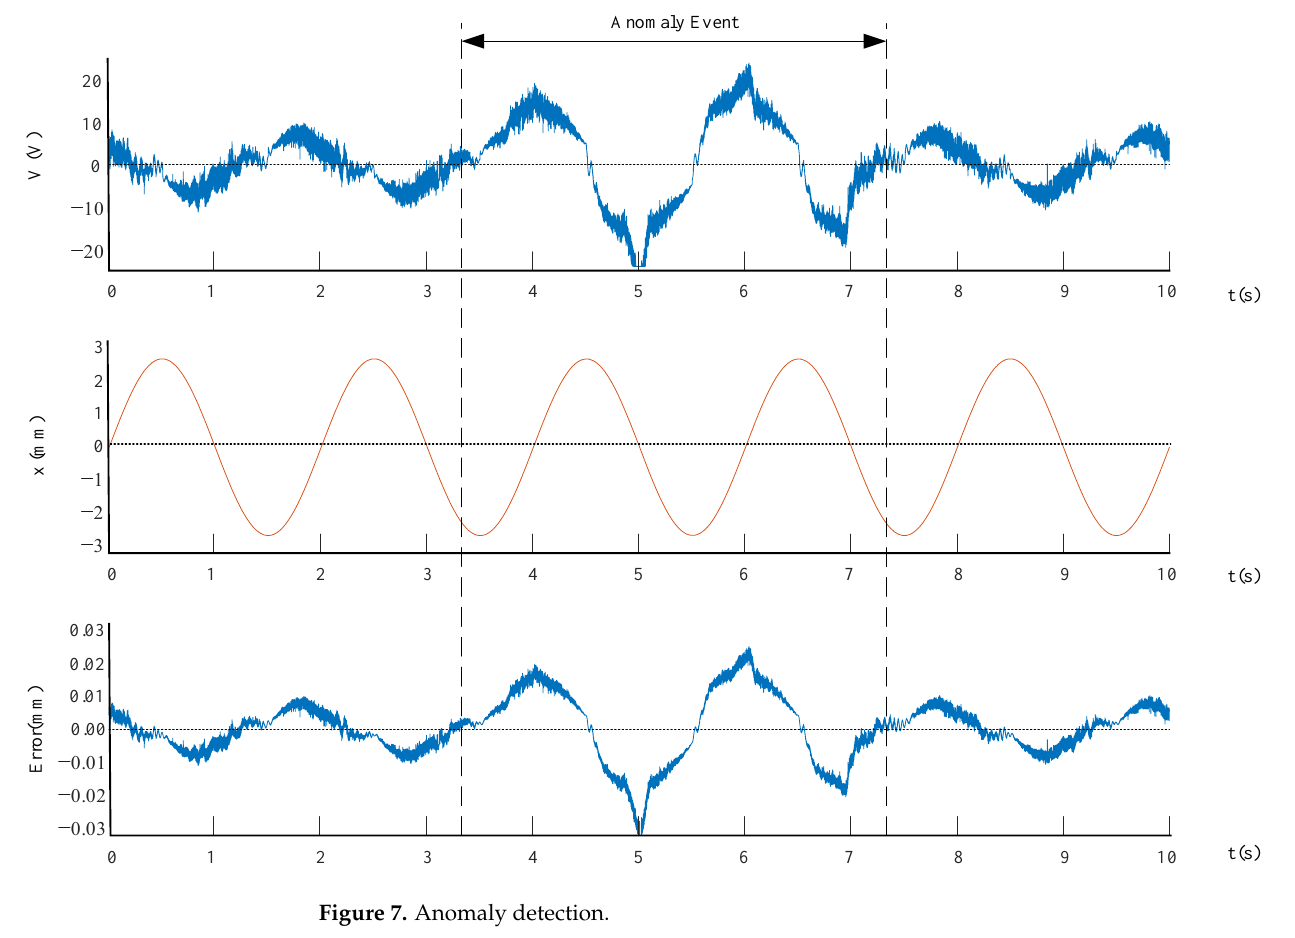
Figure 7. Anomaly detection.